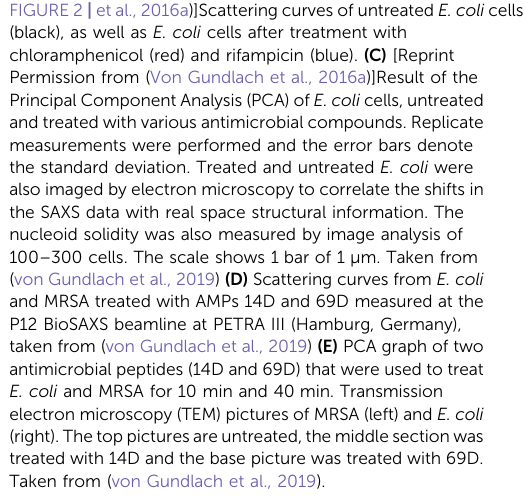
FIGURE 2 (A) Schematic representation of the experimental setting to screen antimicrobial agent-induced ultrastructural intracellular changes by SAXS . (B) [Reprint Permission from (Von Gundlach